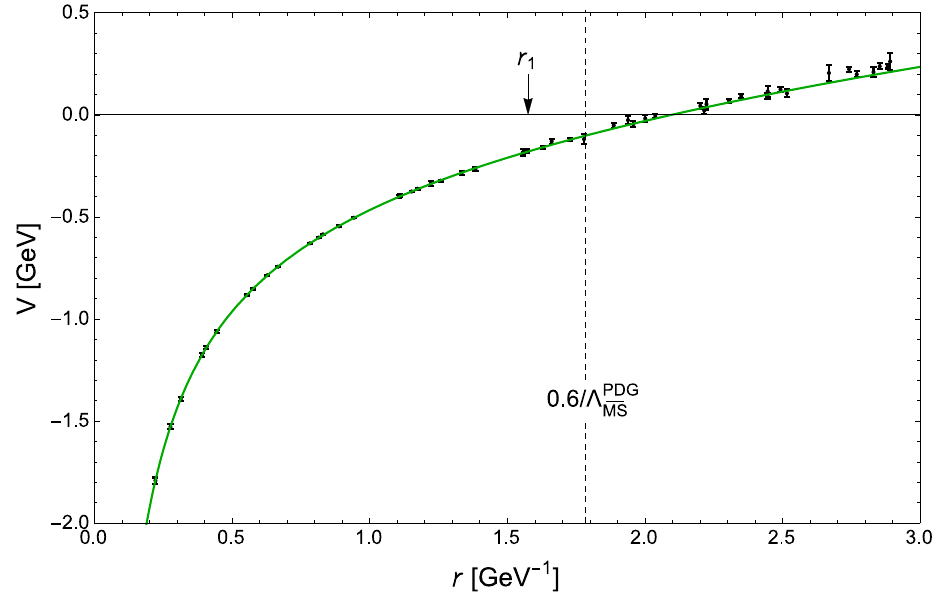
Figure 11 . Lattice result in the continuum limit (black points) and the OPE calculation (green) determined simultaneously by the (cid:12)t in Analysis (II). The distance region used in this (cid:12)t r (cid:3) PDG 0 : 6 is shown by the dotted line. For reference, r = r 1 is also